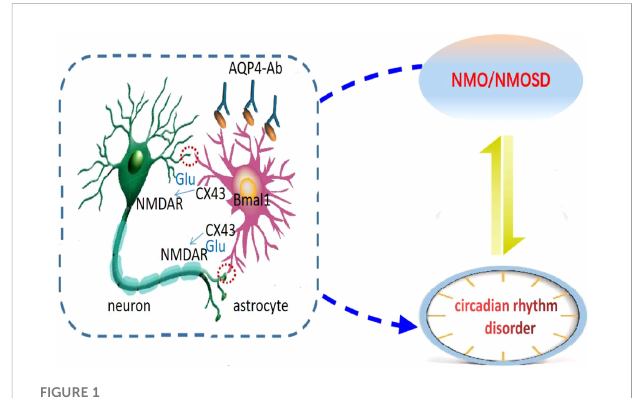
FIGURE 1 Astrocytic regulation hypothesis of circadian disruption in